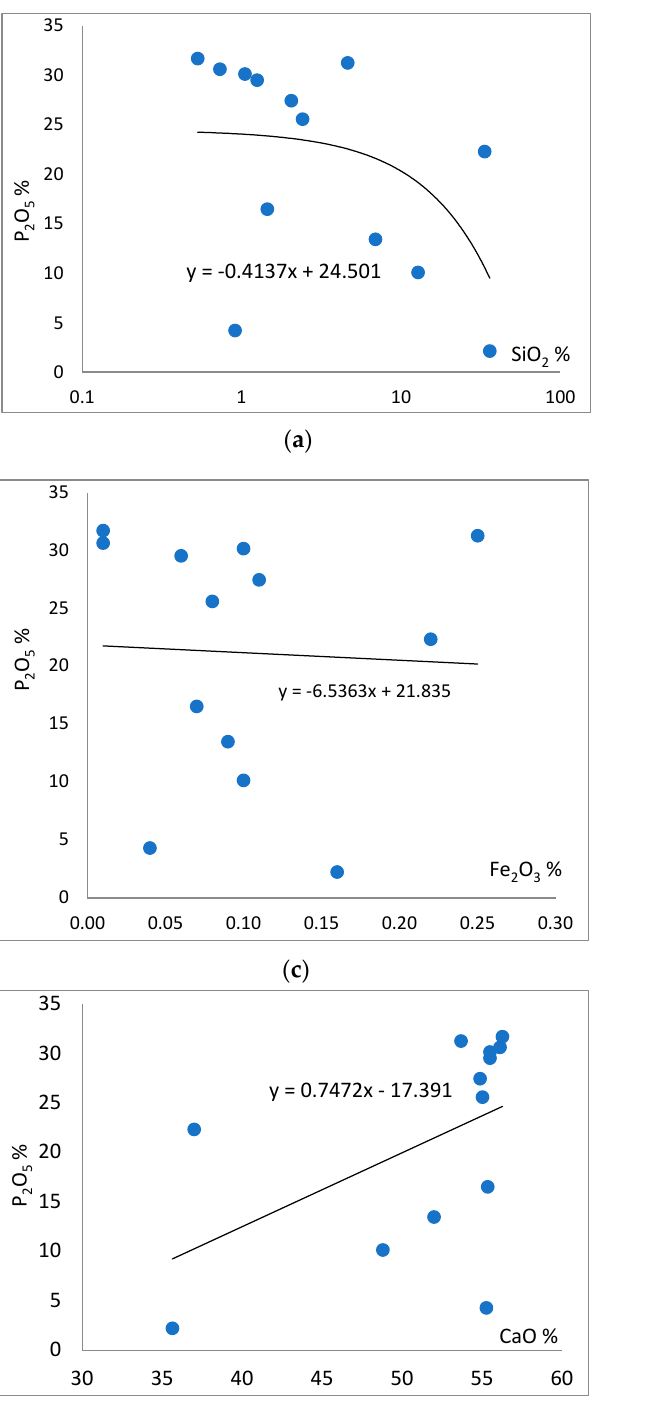
(Figure 6). While the Sr from the large-ion lithophile elements were highly enriched, Rb and Ba were depleted compared to PAAS. Among the high field strength elements (HFSE; Nb, Hf, U, Th, and Zr), Hf, Zr, Nb and Th were significantly lower compared to PAAS, except for U (Figure 6).